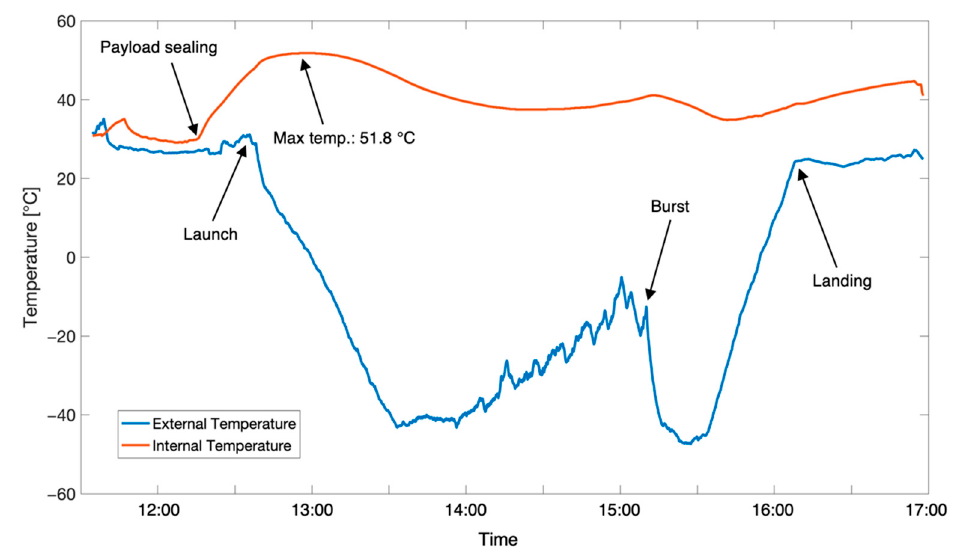
Figure 11. Environmental temperature and temperature inside of the payload gondola during the flight.